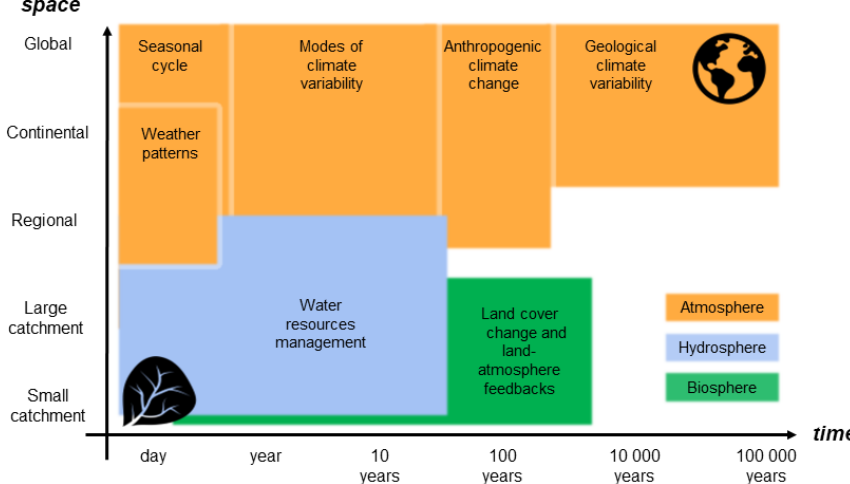
Figure 7. Drivers of nonstationary hydroclimatic extremes by temporal and spatial